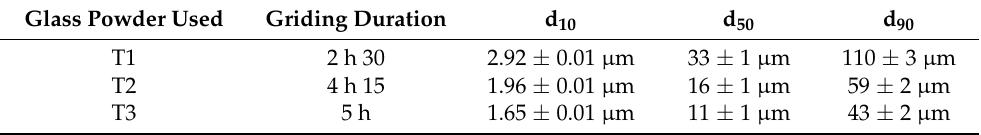
Table 2. Granulometric characteristics of glass powders produced as a function of grinding time. Glass Powder Used